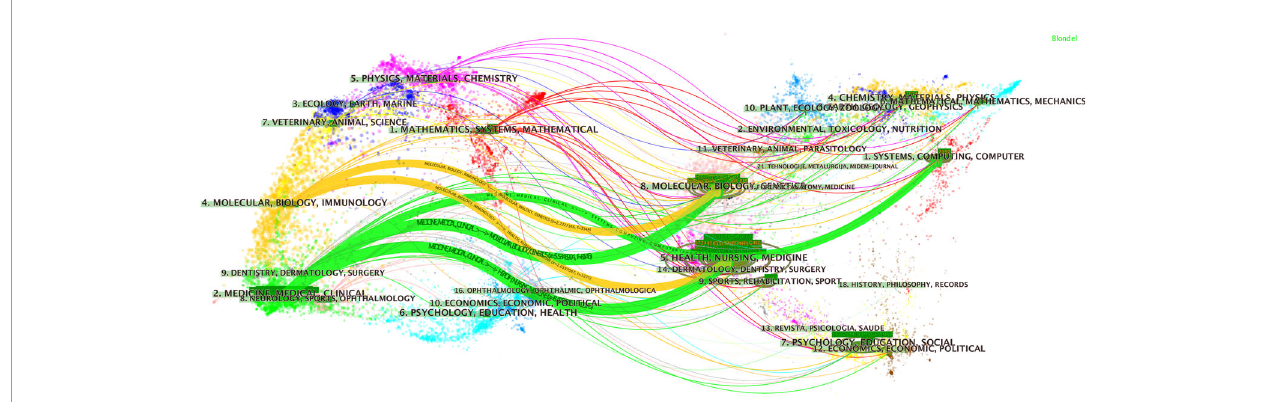
FIGURE 3 | The dual map overlay of journals. This fi gure can be divided into two sections. Each dot represents one journal, and this knowledge map uses different colors to symbolize journals from different subjects. On the left, there are the citing journals of this fi eld, and on the right, lays the cited journals in this fi eld. The waves link to two sides means the publications on the journals of the left side may cite publications from the journals on the other side. For example, publications on journals in the fi eld of medicine medical and clinical (labeled 2 on the left), may refer to the publications on the journal of systems, computing, and computer.